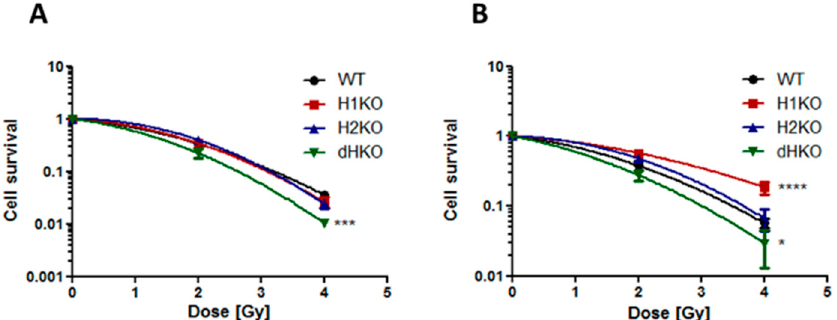
Figure 2. Clonogenic cell survival of H1299 cells irradiated under ( A ) normoxia (21% O 2 ) and ( B ) hypoxia (0.2% O 2 ). Surviving fraction was normalized to vehicle control. Average ± SD of three independent biological repeats is shown. Asterisks indicate statistical significance (* p < 0.05; *** p < 0.001; **** p < 0.0001).